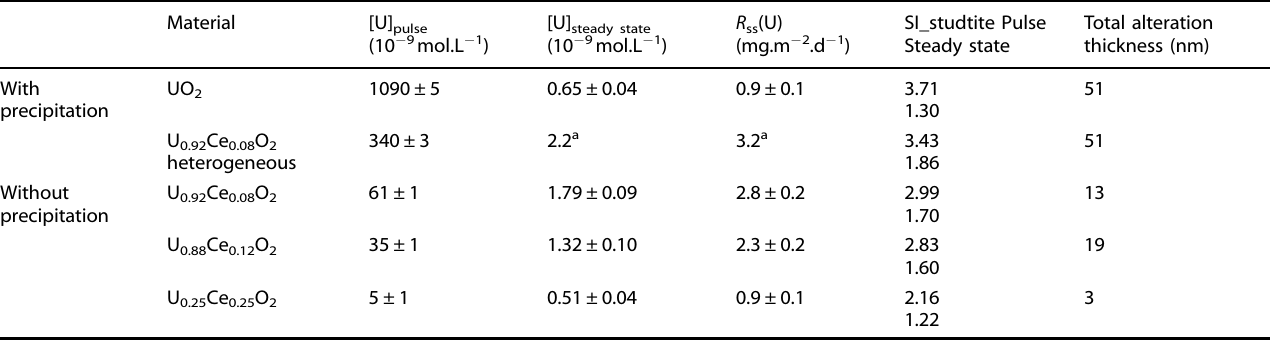
Table 4. Concentrations obtained at the pulse and at the steady state, normalized alteration rate determined at the steady state, saturation index of the solution at the uranium pulse and at the steady state with respect to studtite and total alteration thickness at the end of experiment calculated using Eq. 10.